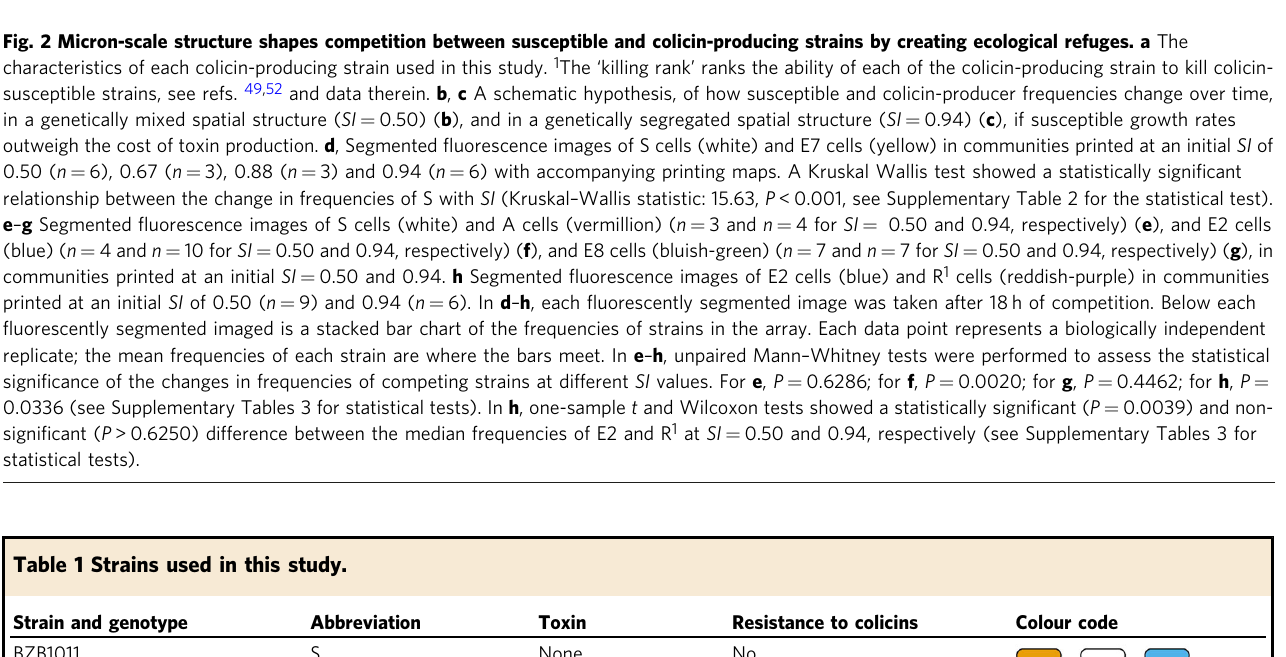
Table 1 Strains used in this